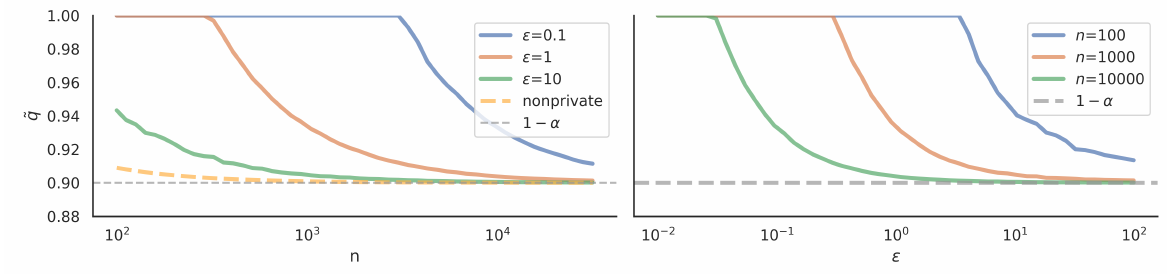
Figure 3: The private quantile ˜ q as n and ϵ grow. We demonstrate the adjusted quantile from (3) as n and ϵ increase, with automatically chosen values for m and γ described in Appendix C. As the number of samples grows and the privacy constraint relaxes, the procedure chooses a less conservative quantile, eventually approaching the limiting value 1 − α . The mild fluctuations in the curves are due to differing choices of m ∗ and γ